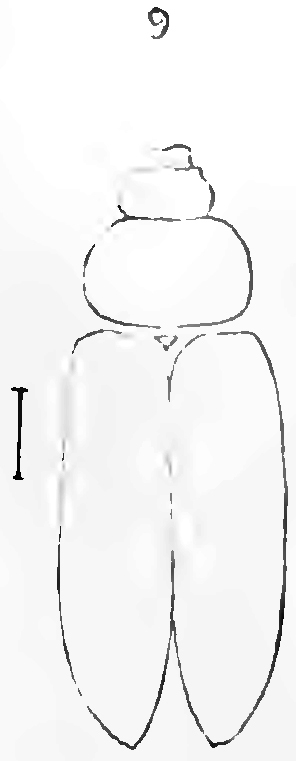
A facsimile of Handlirsch 1906: Tab. XLI, fig. 9. The original illustration of Thoracotes dubius.